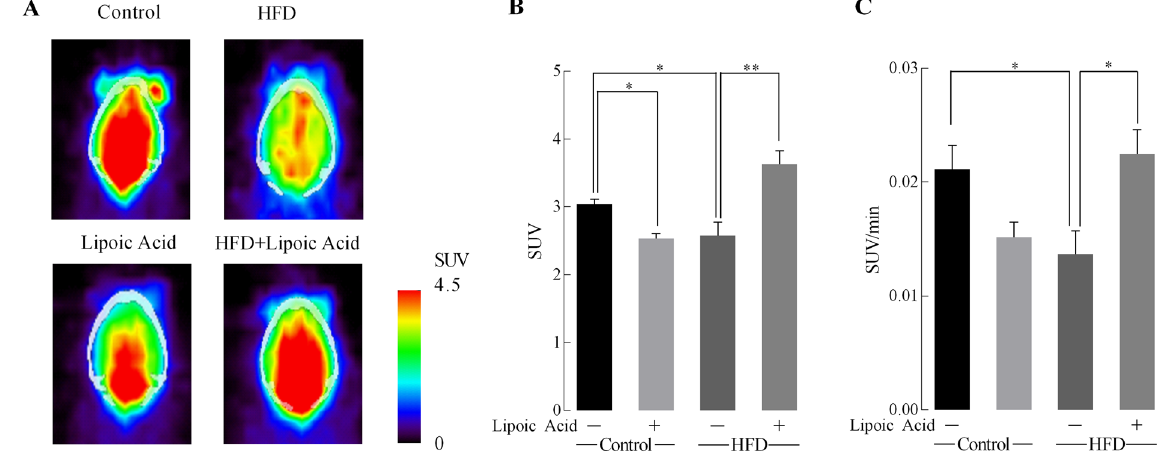
Figure 2. Effect of lipoic acid on brain glucose uptake. ( A ) Representative images of brain glucose uptake ([ 18 F]-FDG microPET/CT) in control, lipoic acid, HFD, HFD + lipoic acid groups at the last scanning